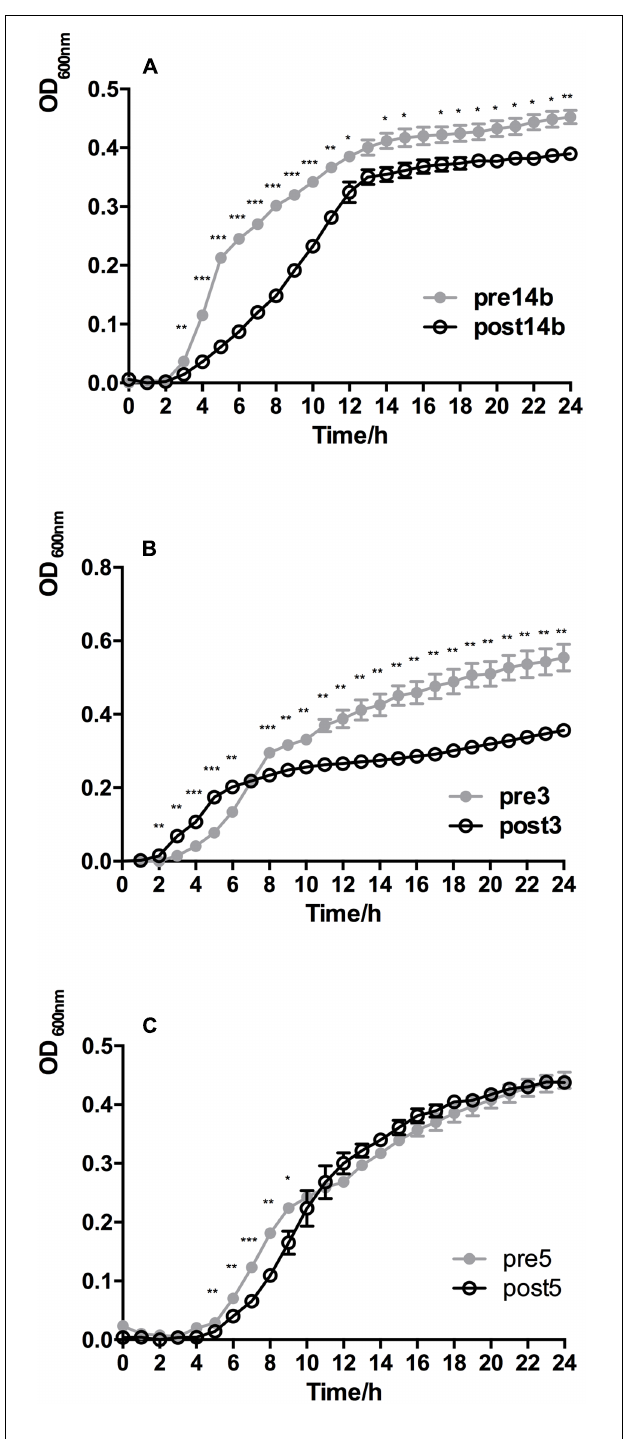
FIGURE 1 | Growth characteristics of DAP-S S. aureus Pre14b, Pre3, and Pre5 strains and their corresponding isogenic derivative Post14b, Post3, and Post5 DAP-R mutants. (A) Pre14b and Post 14b, (B) Pre3 and Post3, and (C) Pre5 and Post5. Strain pairs were grown aerobically in LB liquid culture. The means and standard deviation of three independent experiments are shown. One-way ANOVA was used in statistical analysis. Symbols are defined in the insets. ∗ P < 0.05, ∗∗ P < 0.01, and ∗∗∗ P < 0.001 for DAP-R vs. DAP-S by analysis of